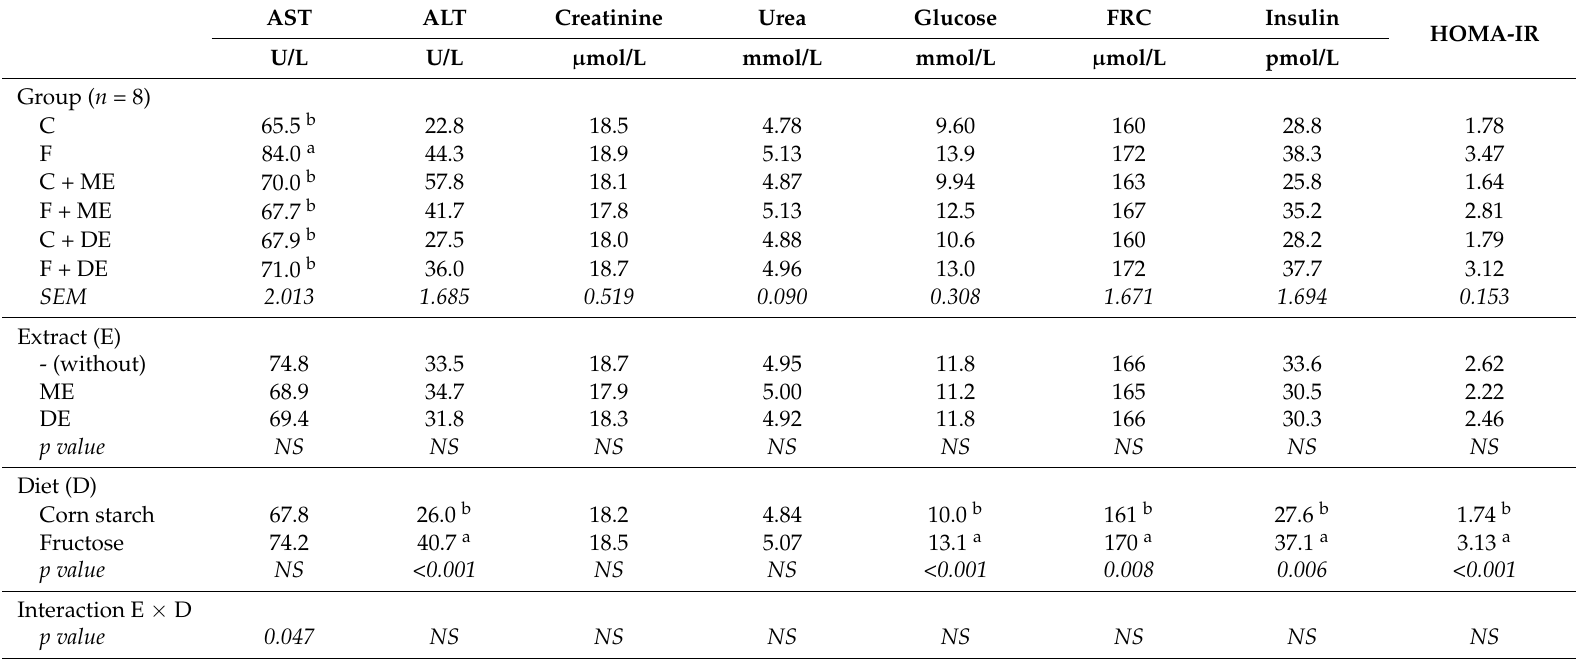
Table 7. Biochemical indicators in the blood serum of rats fed experimental diets